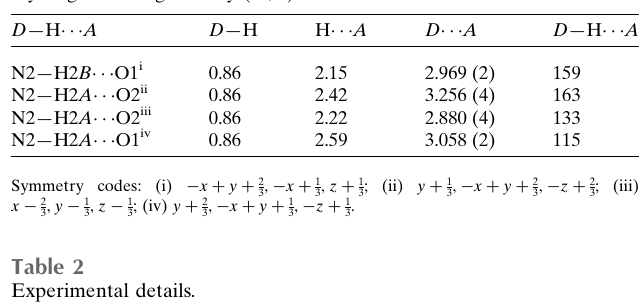
Figure 1 The molecular entities in the complex title salt. Displacement ellipsoids are drawn at the 50% probability level. [Symmetry codes: (1) (cid:3) x , (cid:3) y , (cid:3) z ; (2) (cid:3) y , x (cid:3) y , z ; (3) y , (cid:3) x + y , (cid:3) z ; (4) x (cid:3) y , x , (cid:3) z ; (5) (cid:3) x + y , (cid:3) x , z